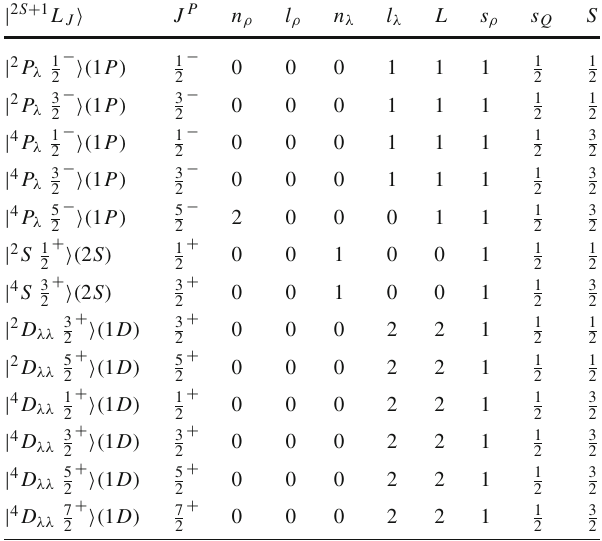
Table 2 The classifications of the low-lying λ -mode 1 P -, 1 D - and 2 S -wave states within the L - S coupling